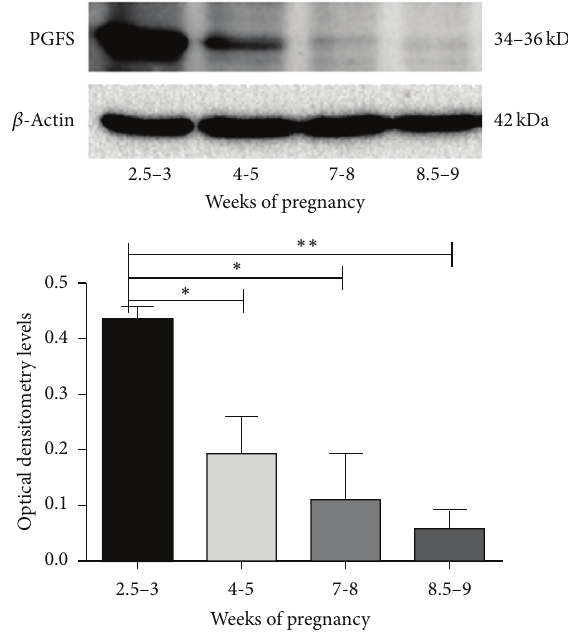
Figure 2: PGFS (AKR1C3) protein expression. Time-dependent expression of PGFS protein in the feline placenta. Tissue homogenates (30 𝜇 g) were used in western blot analysis ( 𝑛 = 16 ). Representative immunoblots are shown. Lower panel represents densitometric values for PGFS normalized against B-actin (mean ±